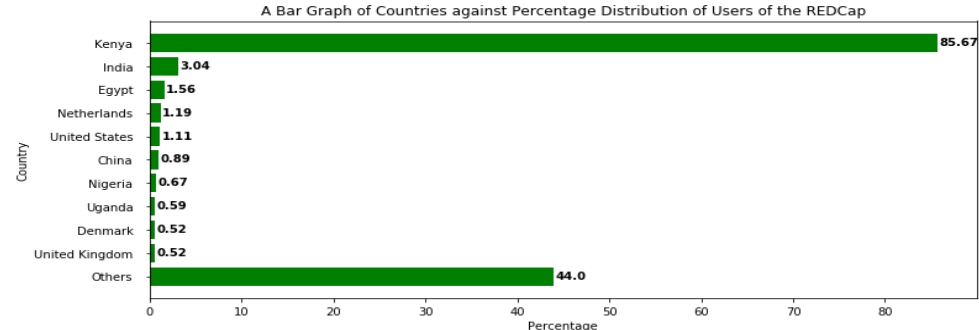
Figure 9. ODK—percentage distribution of users by country.